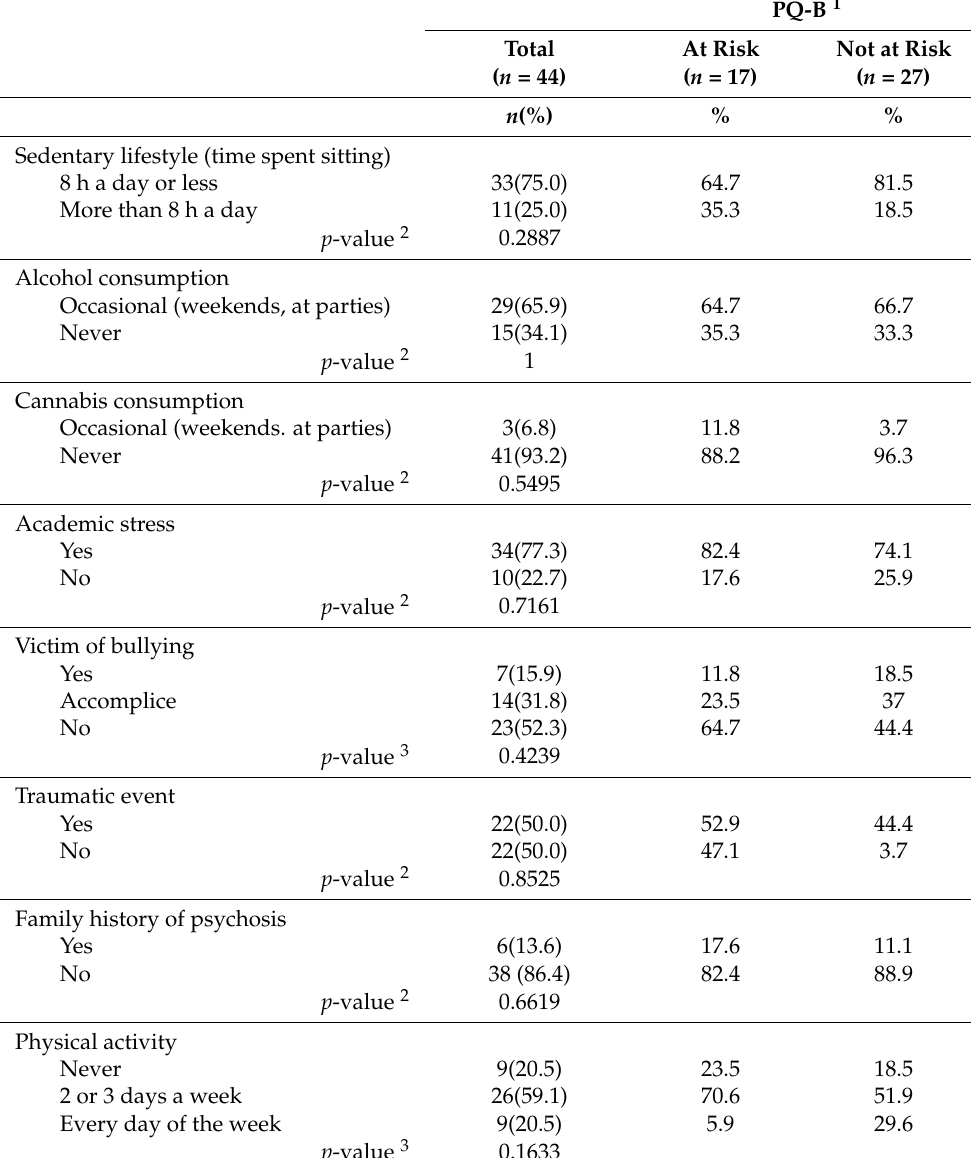
Table 2. Comparison of the percentage prevalence of the participants at risk of psychosis according to the explanatory